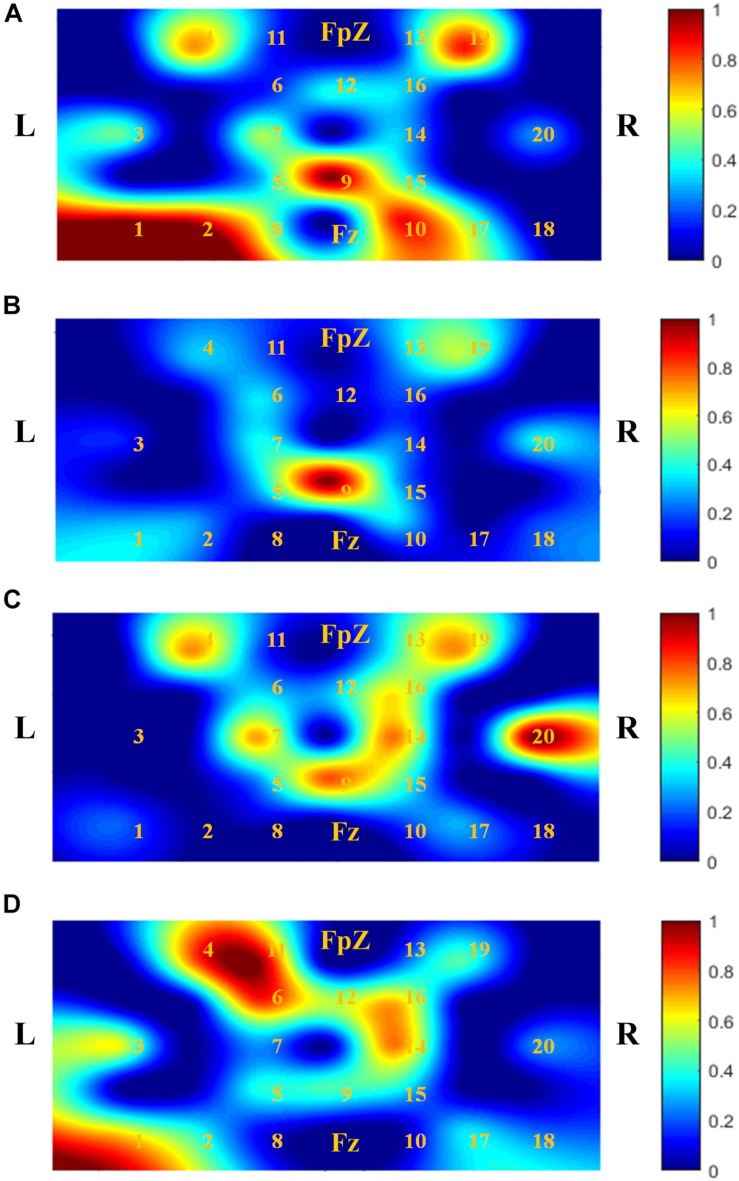
Comparison of activation patterns (t-maps) of ΔHbOs averaged over all subjects and trials: (A)
t-map of HC, (B) MCI-0 [baseline, before acupuncture therapy (AT)], (C) MCI-1 (after 12 sessions of AT for 6 weeks), and (D) MCI-2 (after another 12 sessions of AT for 6 weeks). It is seen that AT makes the activated brain region wider.